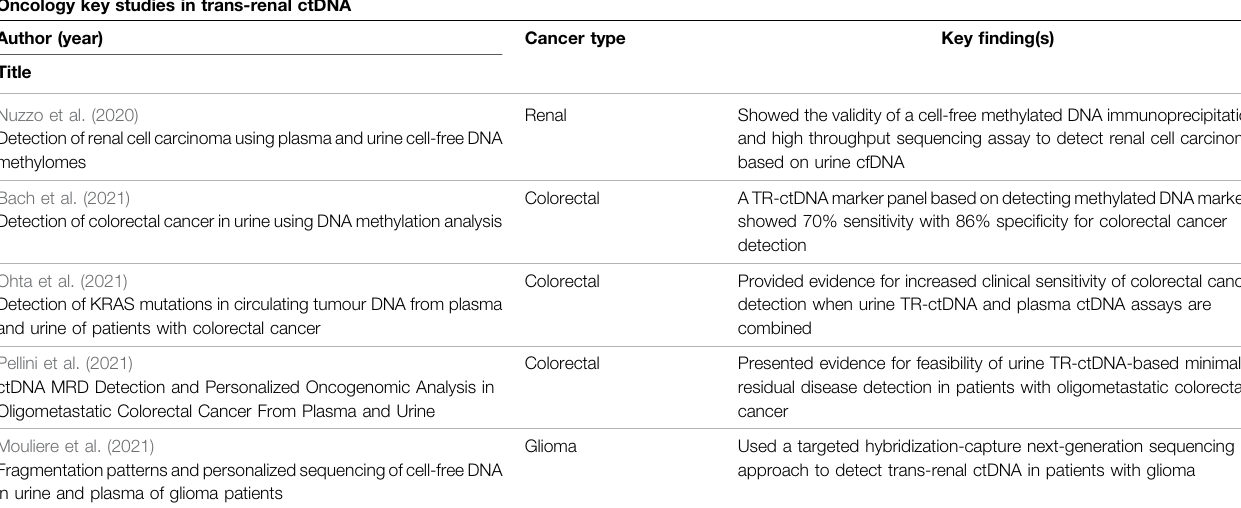
TABLE 1 | ( Continued ) Key Trans-Renal cell-free DNA Studies in Non-Oncology and Oncology